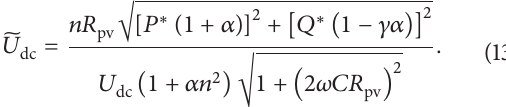
Figure 5: Equivalent circuit for DC voltage